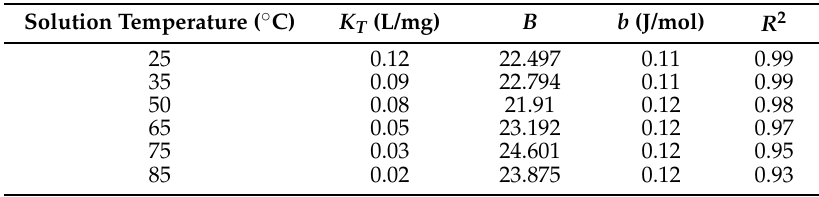
Table 3. Estimated parameters of Temkin isotherm for copper ions sorption onto MANSG at different solution